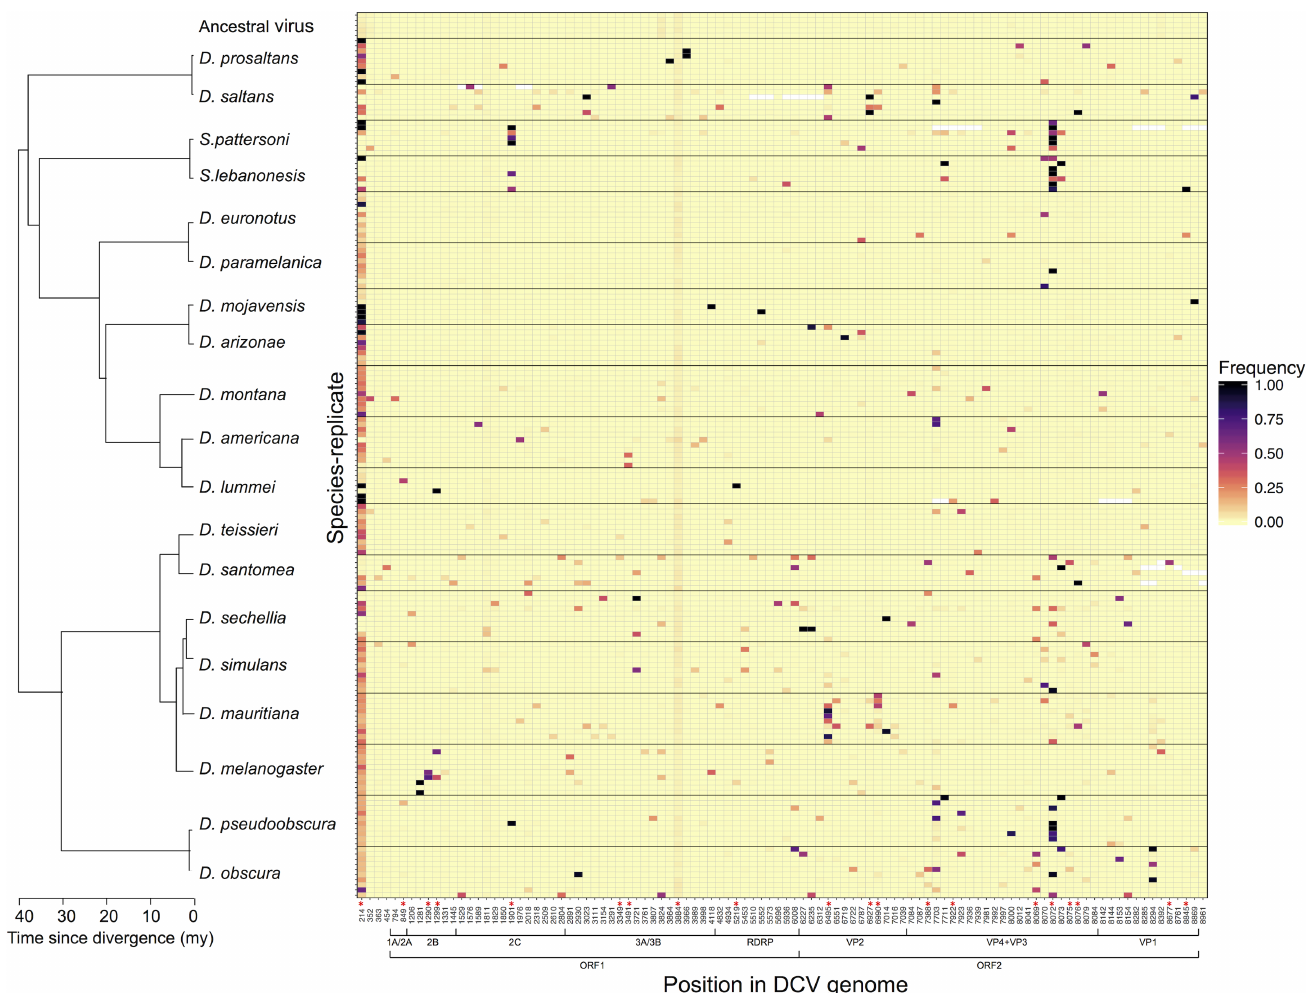
Fig 1. The frequency of SNPs in viral lineages that have evolved in different host species. Each row represents an independent viral lineage. Viruses that evolved in different host species are separated by black horizontal lines. Each column represents a polymorphic site in the DCV genome, and only sites where the derived allele frequency > 0.05 in at least two lineages are shown. The intensity of shading represents the derived allele frequency. Sites where there are three alleles have the two derived allele frequencies pooled for illustrative purposes. Sites with SNP frequencies that are significantly correlated among lineages from the same host species are shown by red stars at the bottom the column (permutation test; p < 0.05). Open reading frames (ORFs) and viral proteins based on predicted polyprotein cleavage sites [38–42] are below the x axis. Information on the distribution of mutations across the genome and whether they are synonymous or non-synonymous can be found in the supplementary results. Sites with missing data are shown in white. The phylogeny was inferred under a relaxed molecular clock [33, 43] and the scale axis represents the approximate age since divergence in millions of years (my) based on estimates from: [35, 36].